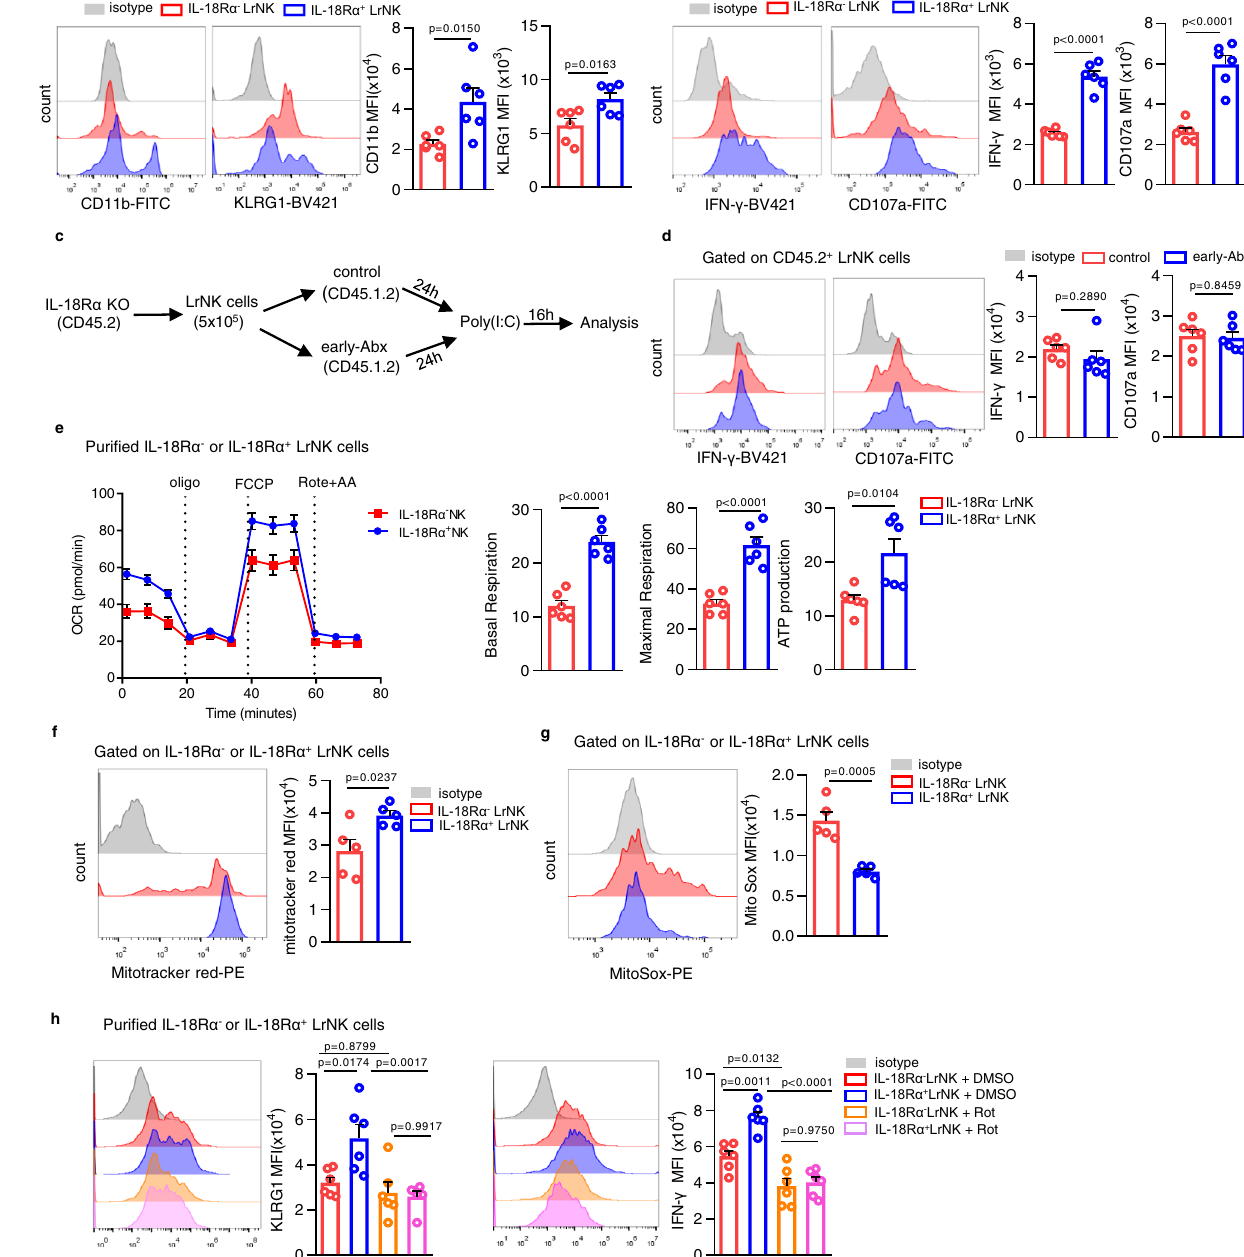
f , g Representative FACS plots and bar graph for the mitochondrial membrane potential, indicated by Mitotracker Red staining and mitochondrial ROS levels measured by MitoSOX in IL-18R α - LrNK and IL-18R α + LrNK cells ( n =5 per group). h Representative FACS plots and bar graph for the expression (MFI) of KLRG1 and IFN- γ in puri fi ed IL-18R α - LrNK or IL-18R α + LrNK cells treated with DMSO or Rote- none ( n =6 per group). Dots represent data from individual mice, and error bars represent SEM per group in one experiment. Statistical analysis was performed by two-tailed Student ’ s t -test ( a – g ) or one-way ANOVA with Tukey ’ s multiple com- parisons test ( h ). * P <0.05; ** P <0.01; *** P <0.001; **** P <0.0001; ns, no signi fi cance. Source data are provided as a Source Data fi